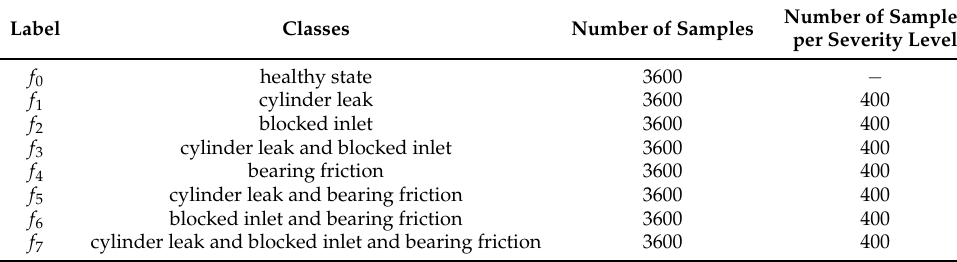
Table 1. Description of 8 different classes of the triplex reciprocating pump